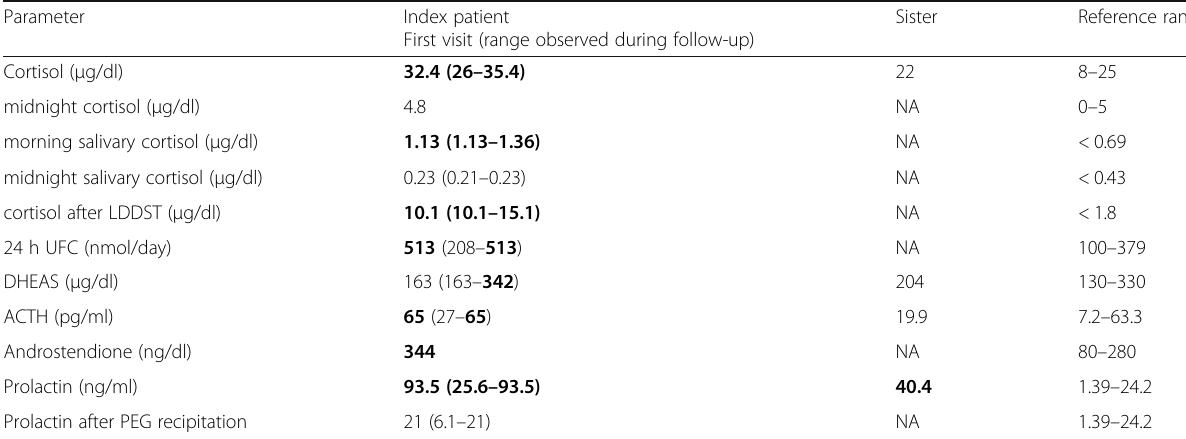
Table 1 Laboratory results of the index